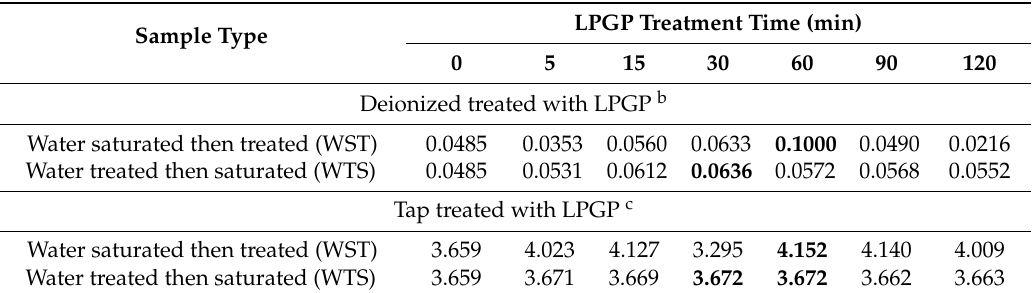
Table 2. Conductivity (mS / cm) a of water treated under oxygen with low pressure glow plasma of low frequency